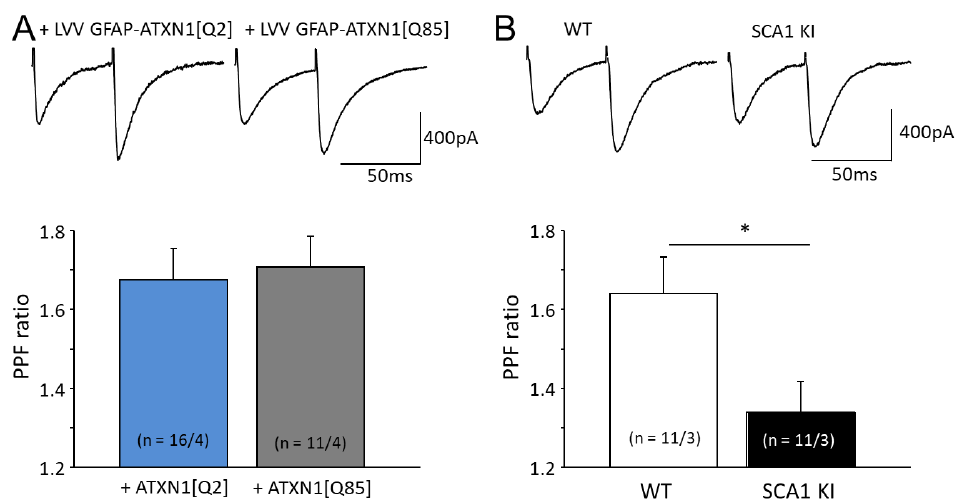
Figure 3. Impairment of presynaptic short-term plasticity in PF-PC synapses in SCA1 models. ( A ) Top—PPF in PC in response to PF stimulation, averaged traces. Below—PPF ratio is not affected in mice that express ATXN1[Q85] selectively in BG. ( B ) PPF is reduced in PF-PC synapses of SCA1 KI mice. The numbers ( n ) of tested PCs and animals (PCs/animals) are shown in parentheses. Asterisks indicate a statistically significant difference compared to respective controls ( t -test; * p < 0.05). On the other hand, CF synapses, formed by axons of inferior olivary nucleus neurons with PC, typically display a reduction of the second response, known as paired pulse depression (PPD). PPD In animals expressing ATXN1[Q85] selectively in BG, the PPD ratio in CF-PC synapses was not